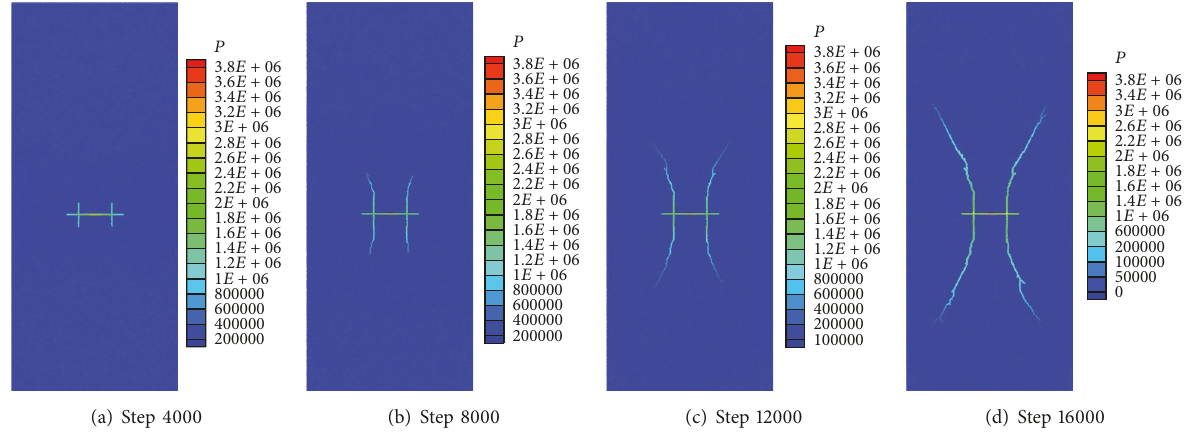
Figure 21: Propagation of two initially parallel fractures driven by hydraulic pressure: isotropic in situ stress field.